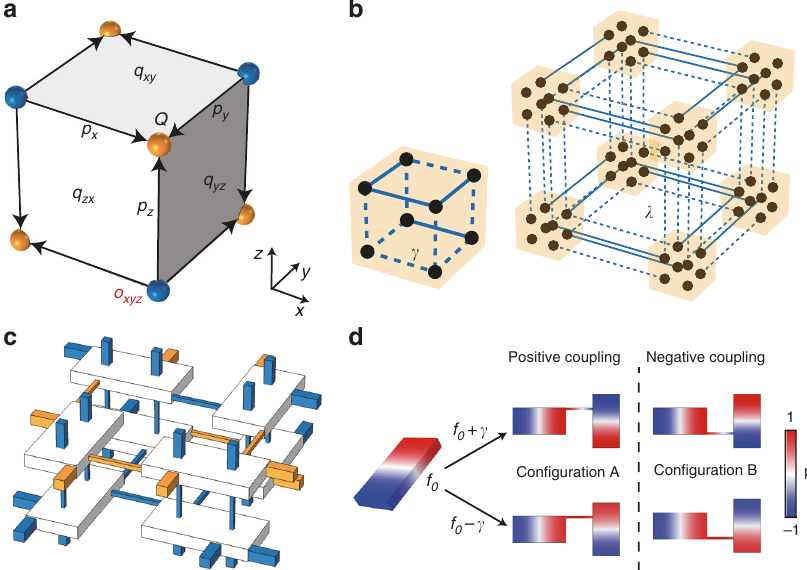
Fig. 1 Octupole topological insulator and its acoustic metamaterial realisation. a Schematic of a bulk octupole moment, which induces surface quadrupole moments, edge dipole moments and corner charges. b Tight-binding model of a quantised octupole topological insulator. The left (right) panel illustrates the intra-cell (inter-cell) couplings. Here, solid and dashed lines represent positive and negative couplings, respectively. c Acoustic metamaterial realisation of the model in b , showing one unit cell consisting of eight resonators coupled by thin waveguides (orange and blue colours denote positive and negative couplings, respectively). d Implementation of negative coupling with coupled acoustic resonators. The left panel shows the dipole mode of a single resonator. The right panel shows the eigenmodes of two coupled-resonator systems with coupling waveguides located at different sides of the resonance ’ s nodal line, corresponding to opposite coupling